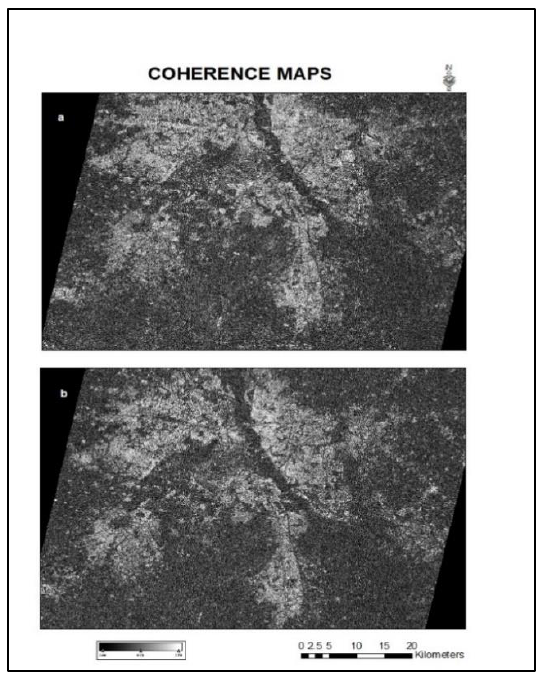
Figure 4 Coherence image generated from two images of NCR area of India, with a time interval of 12 days by (a) VV polarization and (b) VH polarization